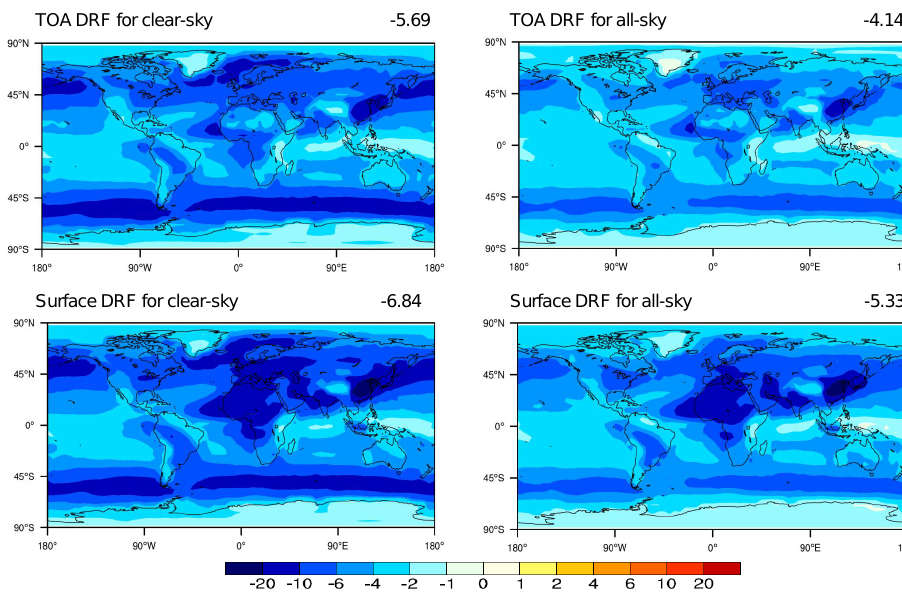
Fig. 5. Total aerosol DRF from all aerosols at TOA and surface for both clear sky and all sky. Unit:Wm − 2